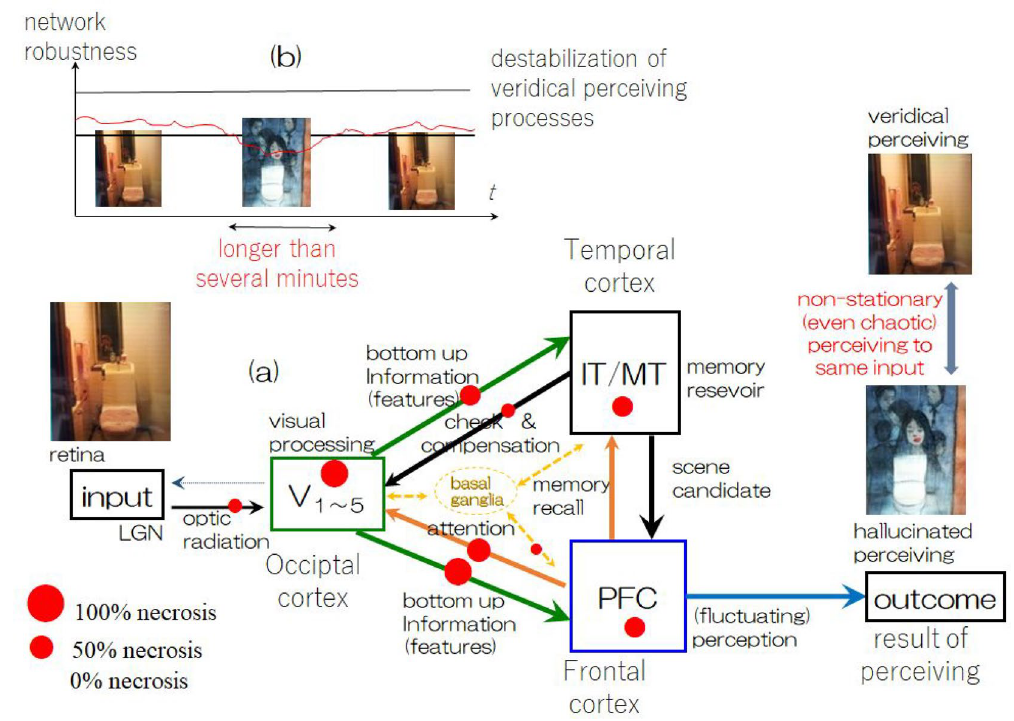
Figure 8. ( a ) Our concluding scenario of RCVH-DLB based on our investigation about of the pathological consideration mechanism of DLB and the computer experiments using our three-module model. Red colors in the block diagram indicate atrophy determined by computer experiments shown in Fig. 7. ( b ) Schematic figure of the transient appearance of the hallucinatory state expected by introducing certain fluctuations of in the thresholds of neurons in each